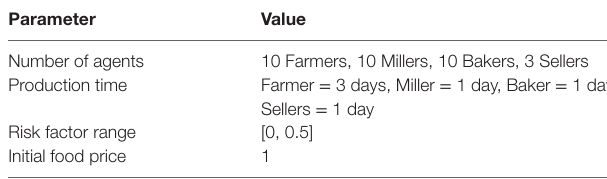
TaBle 2 | initial conditions for experiment #1.